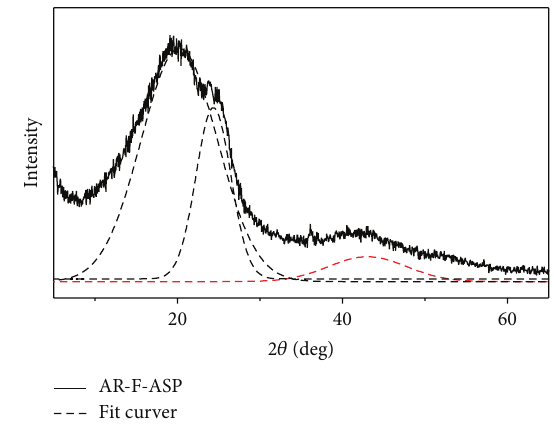
Figure 3: Deconvoluted XRD pattern of asphaltene of atmospheric residue (AR-F-ASP as an example).